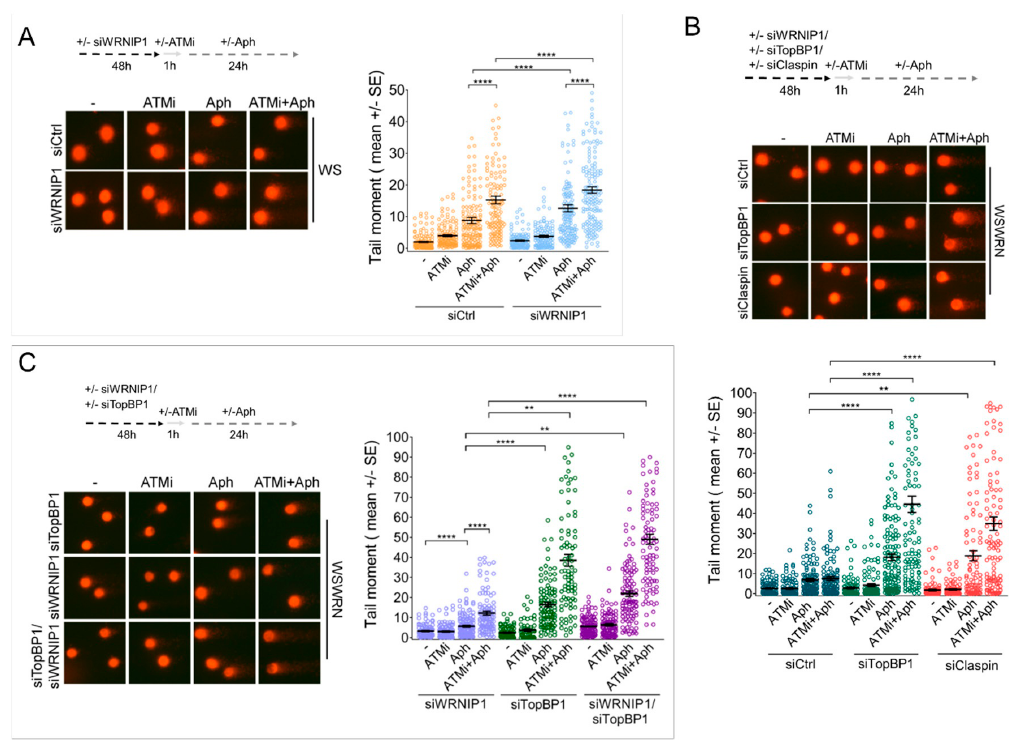
Figure 4. Cells with defective ATR-CHK1 signaling exhibit enhanced sensitivity to combined loss of ATM activity and WRNIP1. ( A ) Alkaline comet assay in WS cells transfected with GFP or WRNIP1 siRNA and treated as in the scheme. Data are presented as tail moment ± SE from three independent experiments; ( B ) Alkaline comet assay in WSWRN cells after TopBP1 or Claspin depletion in WSWRN cells as reported in the scheme. Data are presented as tail moment ± SE from three independent experiments; ( C ) Alkaline comet assay in WSWRN cells after TopBP1 and/or WRNIP1 depletion as reported in the scheme. Data are presented as tail moment ± SE from three independent experiments.